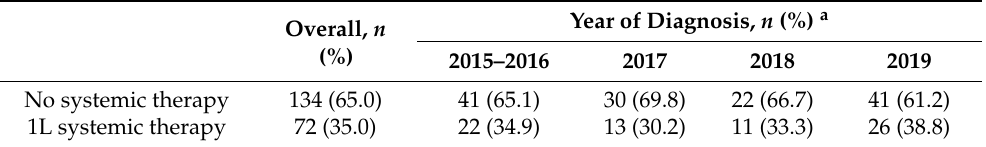
Table 2. Numbers of incident cases of patients with de novo la/mUC who received no systemic therapy, and of patients with de novo la/mUC who received 1L systemic therapy.